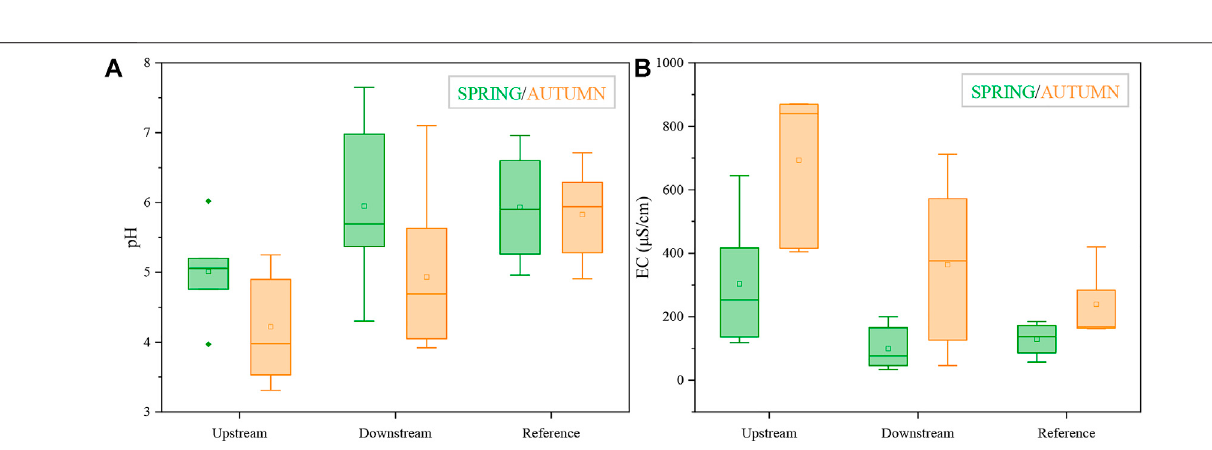
Frontiers in Environmental Science |